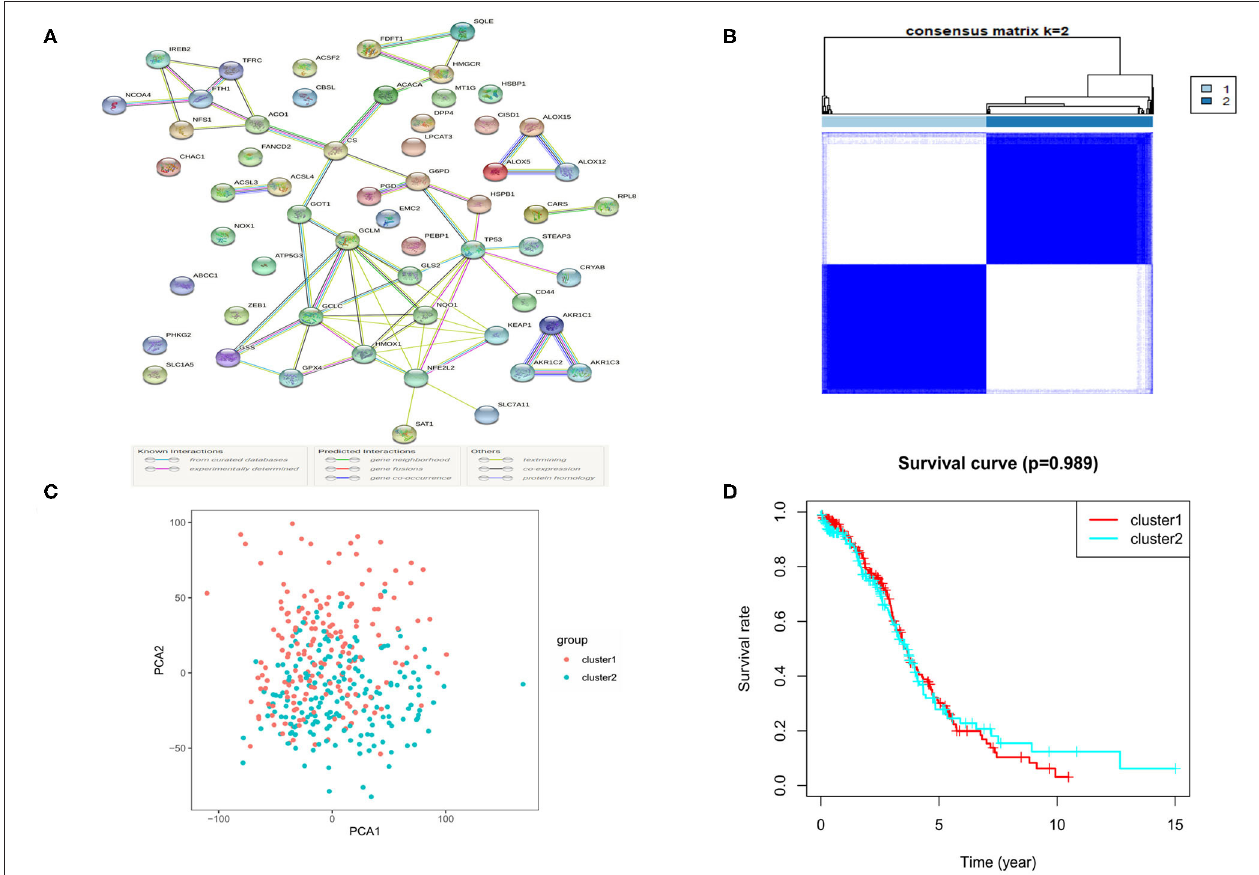
FIGURE 2 | The Consensus clustering for 379 OC samples based on the DEGs. (A) PPI network showing the interactions of DEGs. (B) Consensus clustering matrix for k = 2. (C) PCA plot for the consensus clustering matrix. (D) Kaplan-Meier OS curves for the OC patients in the 2 clusters.